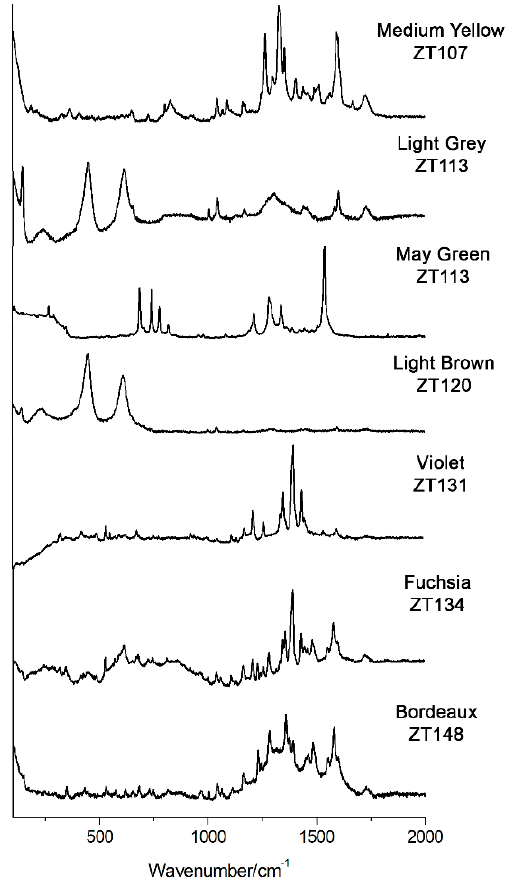
Figure 4. Raman spectra of the commercial sprays of the Decor brand. Table 1. Elements identified in the commercial sprays. The major elements were considered up to 10% of relative presence. The elements with less than 1% were not included. The elements were ordered by taking into account their relative